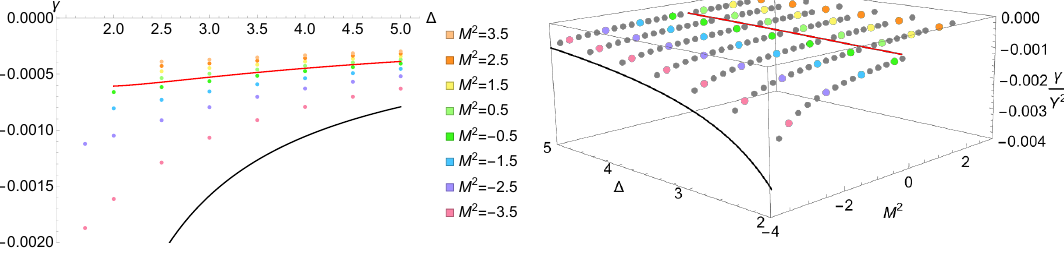
Figure 2 . Contribution to the binding energy γ for different scaling dimensions of φ , ∆ , and scalar mass of χ , M . Black and red lines represent binding energies for the analytically accessible cases M 2 = − 4 (3.40) and M 2 = 0 (3.37)